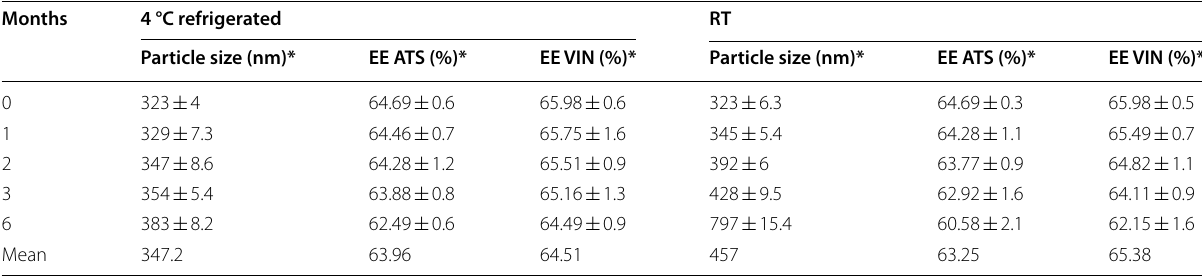
Table 9 Stability studies data of